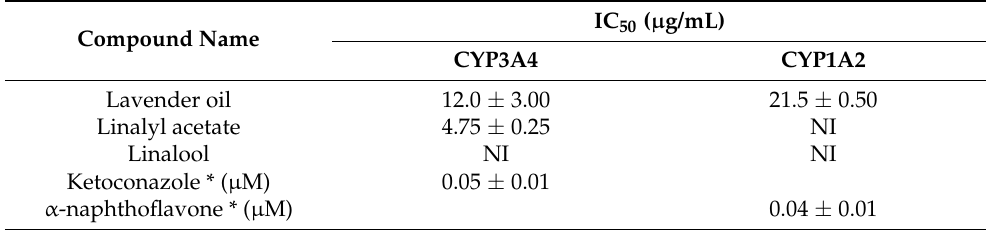
Table 1. IC50 values for inhibition of CYP3A4 and CYP1A2 catalytic activity. The data are represented as mean ± SD. NI = no inhibition.